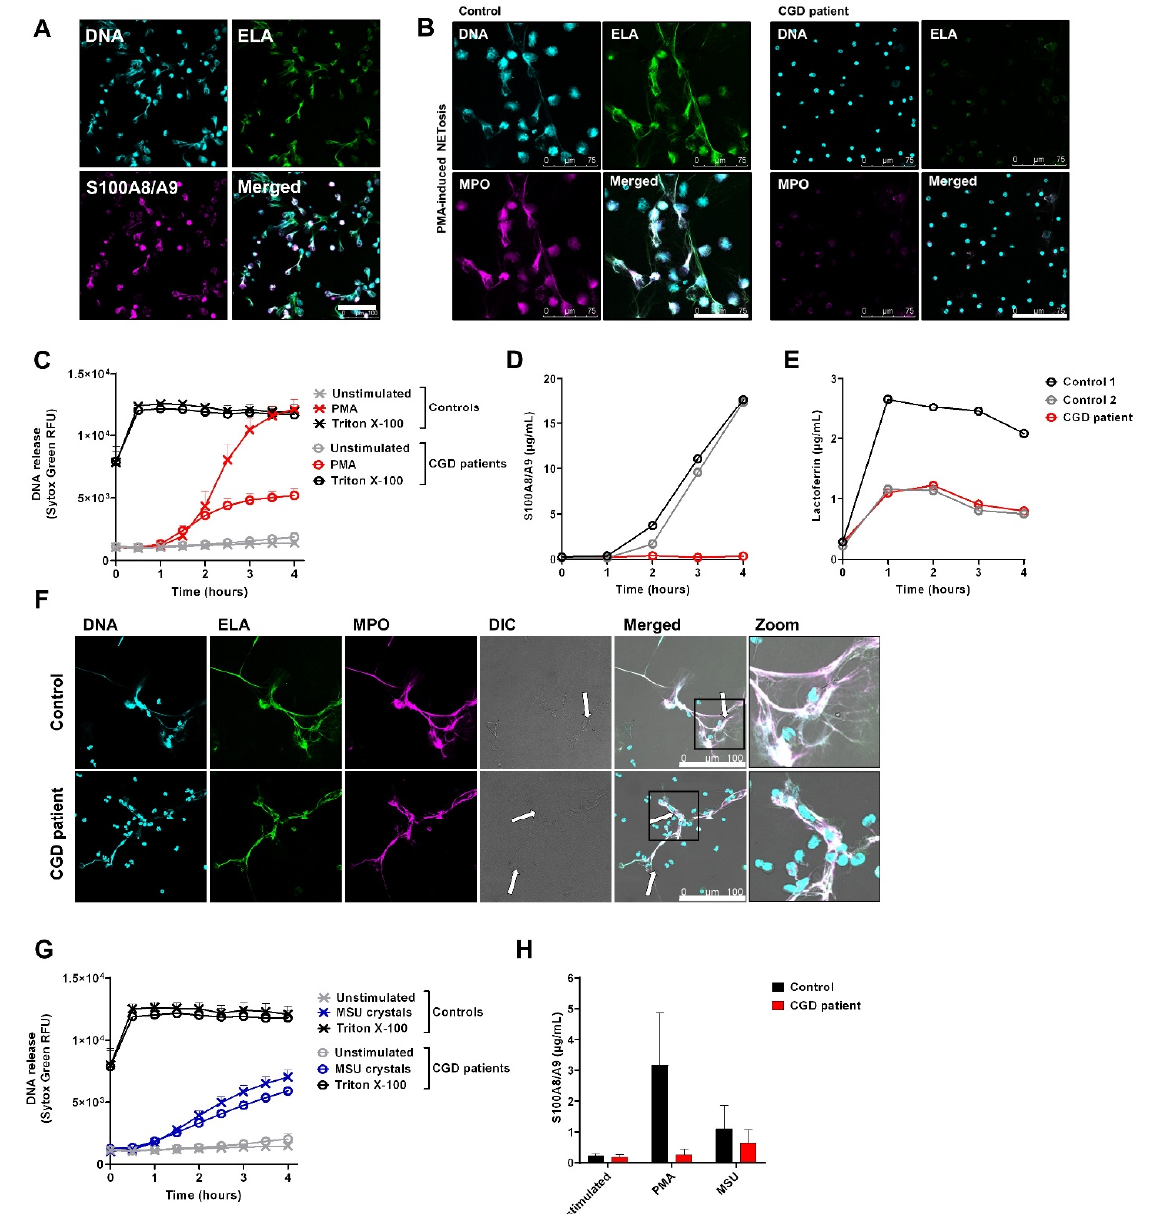
Figure 2. S100A8/A9 release by neutrophils upon NETosis. To induce NET formation, neutrophils were stimulated with ( A – E ) PMA (100 ng/mL) or ( F – H ) MSU crystals (200 µg/mL) for 4 h at 37 °C. ( A , B , F ) NETs were visualized by staining for Elastase (ELA) (green, 488), DNA (Hoechst, blue, 405), and ( A ) S100A8/A9 or ( B , F ) myeloperoxidase (MPO) (magenta, 633). Images were acquired using a Leica SP8 confocal microscope, magnification 400×. Scale bar = ( A , F ) 100 µm or ( B ) 75 µm. ( C , G ) DNA release of neutrophils was measured by Sytox Green Nucleic Acid Stain upon stimulation with ( C ) PMA (n = 8 for controls and n = 4 unique CGD patients, of which one patient was measured three times, mean + SEM) or ( G ) MSU crystals (n = 5 for controls and n = 3 unique CGD patients, of which one patient was measured two times, mean + SEM). Triton X-100 was used as positive control. ( D , E ) Supernatant of PMA-stimulated neutrophils was collected at the indicated time points and measured for ( D ) S100A8/A9 and ( E ) lactoferrin by ELISA. ( F ) Arrows indicate NET structures around MSU crystals. ( H ) Supernatants of neutrophils stimulated for 4 h with PMA or MSU crystals were collected and measured for S100A8/A9 by ELISA (n = 2 for controls, n = 2 for CGD patients, mean + SEM). CGD = chronic granulomatous disease.